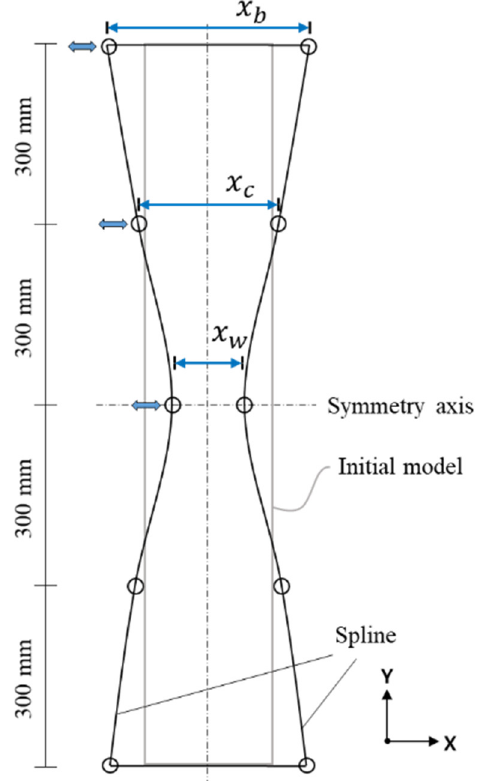
Figure 4. Specifications of the control points.